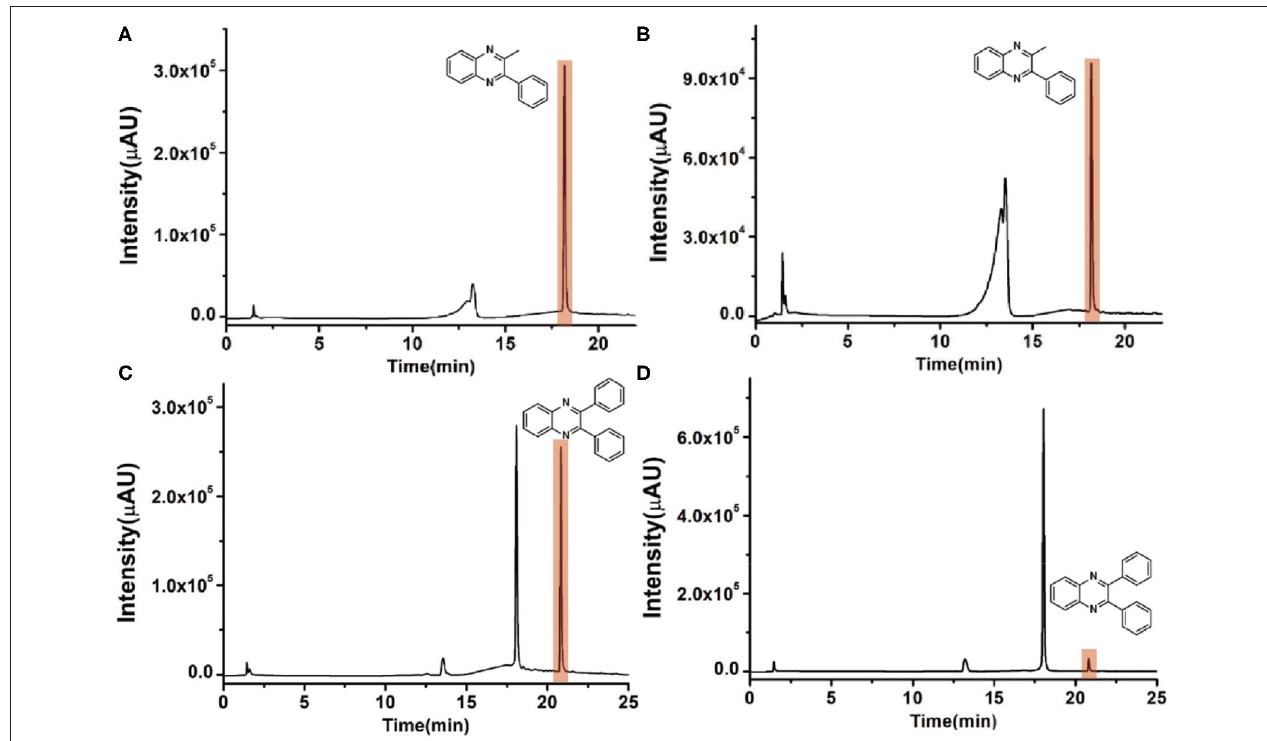
FIGURE 4 | Chromatographic results of LC-MS for the reaction of (A) benzene-1,2-diamine and 1-phenyl-1,2-propanedione under microdroplet conditions. (B) benzene-1,2-diamine and 1-phenyl-1,2-propanedione in bulk solution. (C) Benzene-1,2-diamine and bibenzyl under microdroplet conditions. (D) Benzene-1, 2-diamine and bibenzyl in bulk